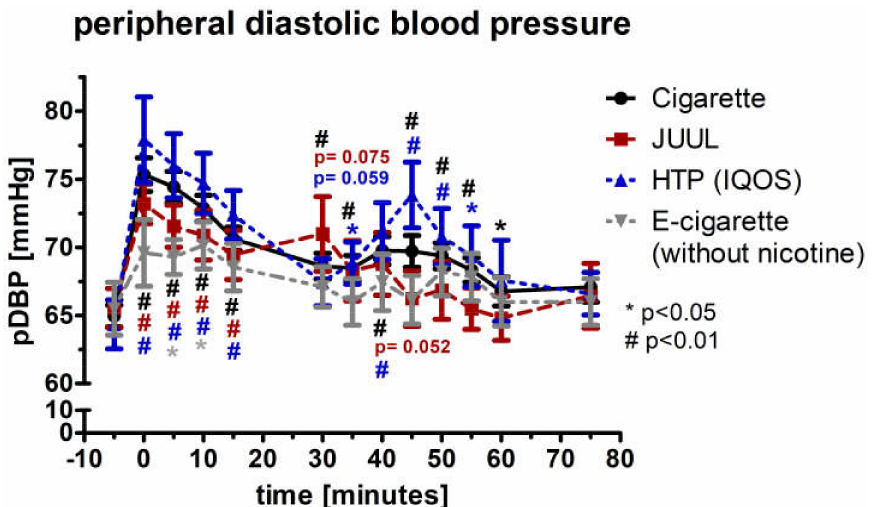
Figure 4. Peripheral diastolic blood pressure in a frequency of 5 min until 75 min after consuming the cigarette, JUUL TM , heated tobacco product, and e-cigarette without nicotine. There was a significant increase in the peripheral diastolic blood pressure right after the consumption of the cigarette, JUUL™, and heated tobacco product.